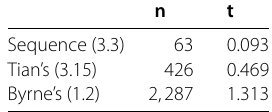
Table 3 (cid:2) = 10 –5 , P = 10, M = 10, N = 10